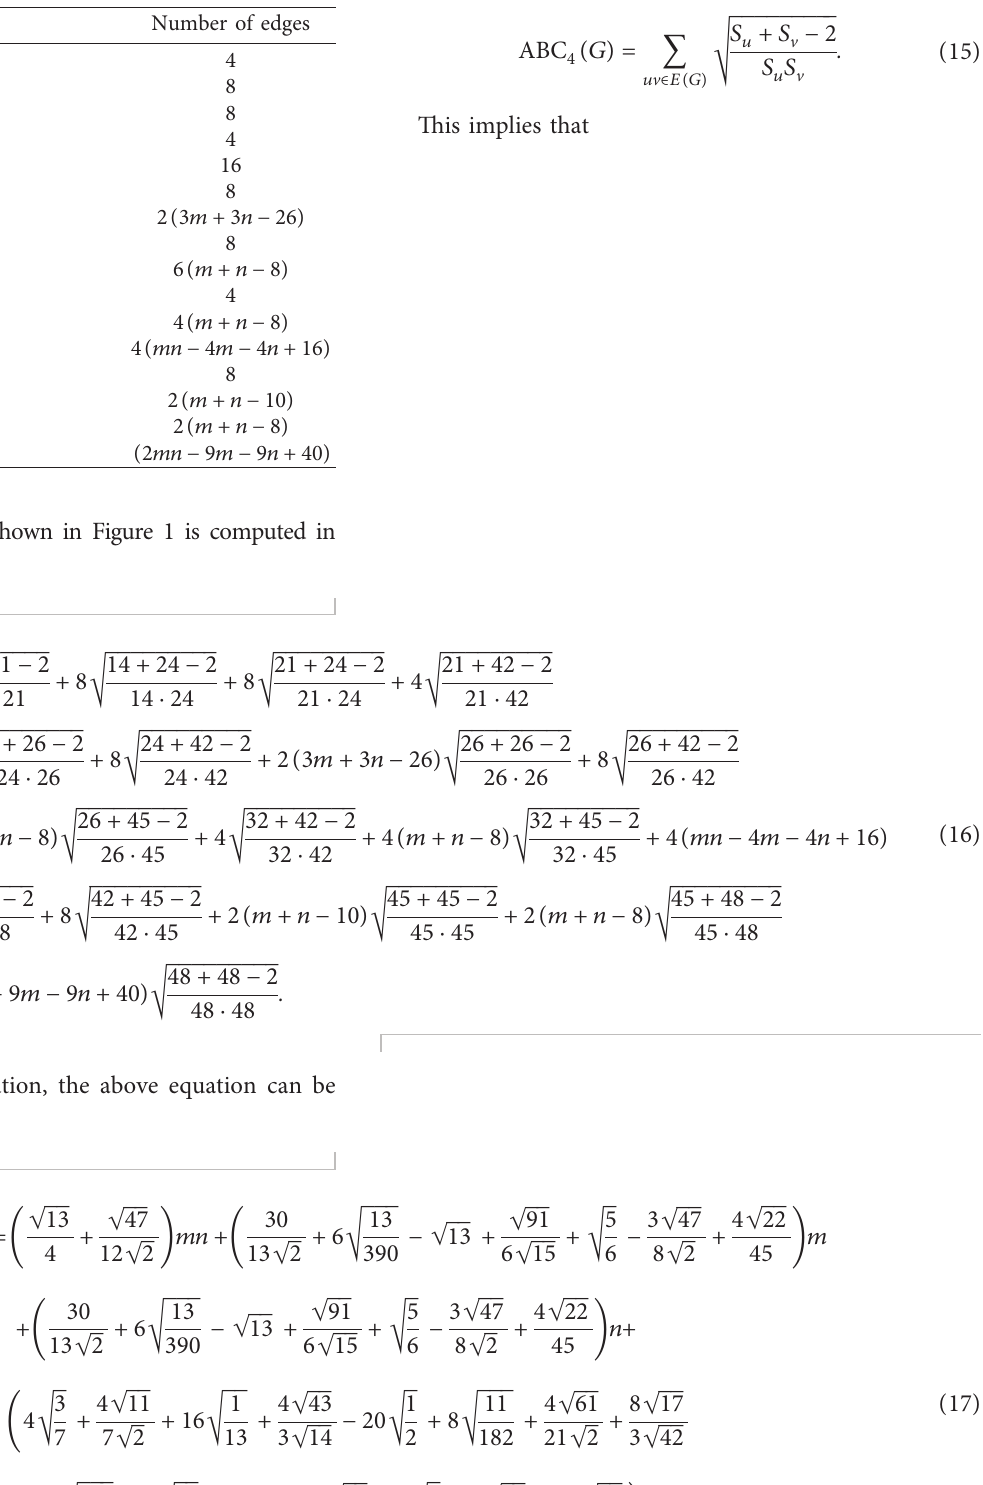
Table 2: Edge partition of EM ( m, n ) on the basis of the sum of vertices which is a distance unit from the end vertices of each